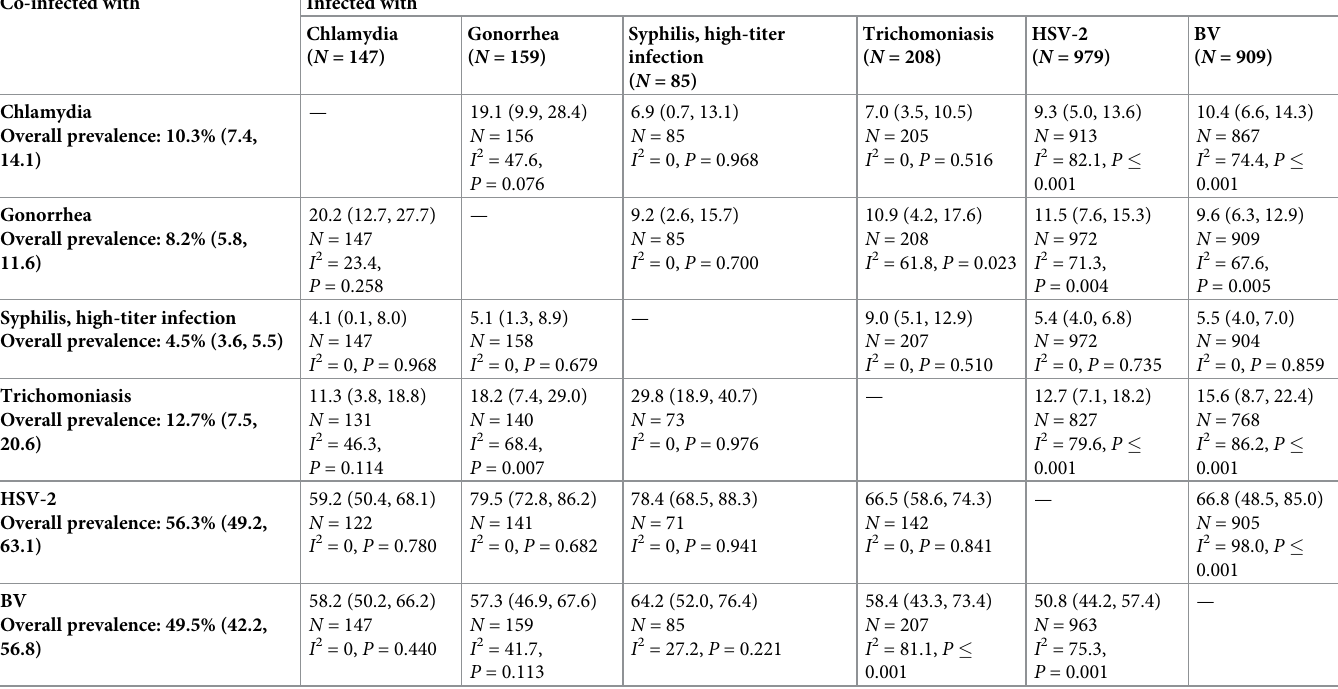
Table 8. Proportion of participants with each infection who are co-infected with an additional STI or BV among women aged 15–24 years in Eastern African higher-risk populations. Co-infected with